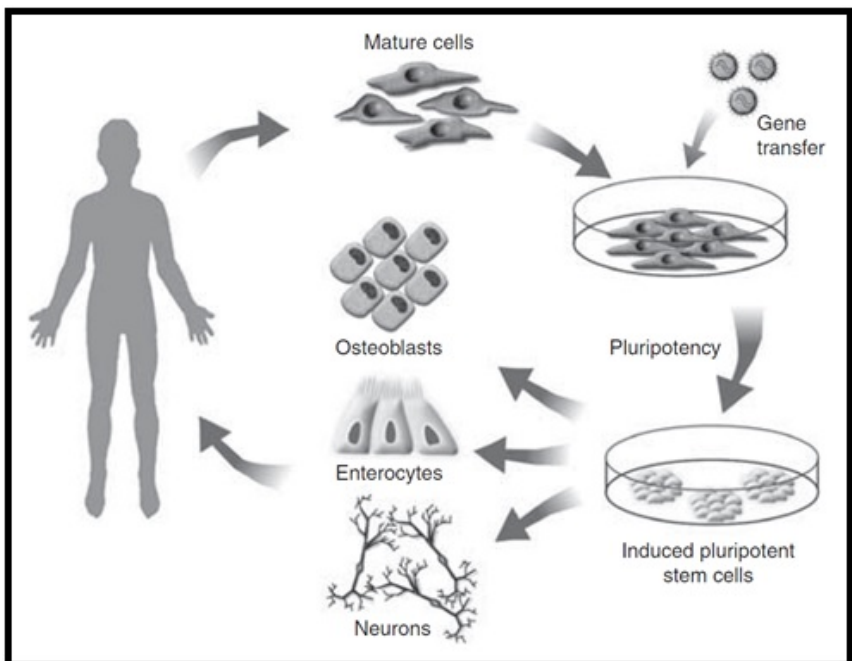
Figure 6. Induced pluripotent stem cell cultivation [78] .